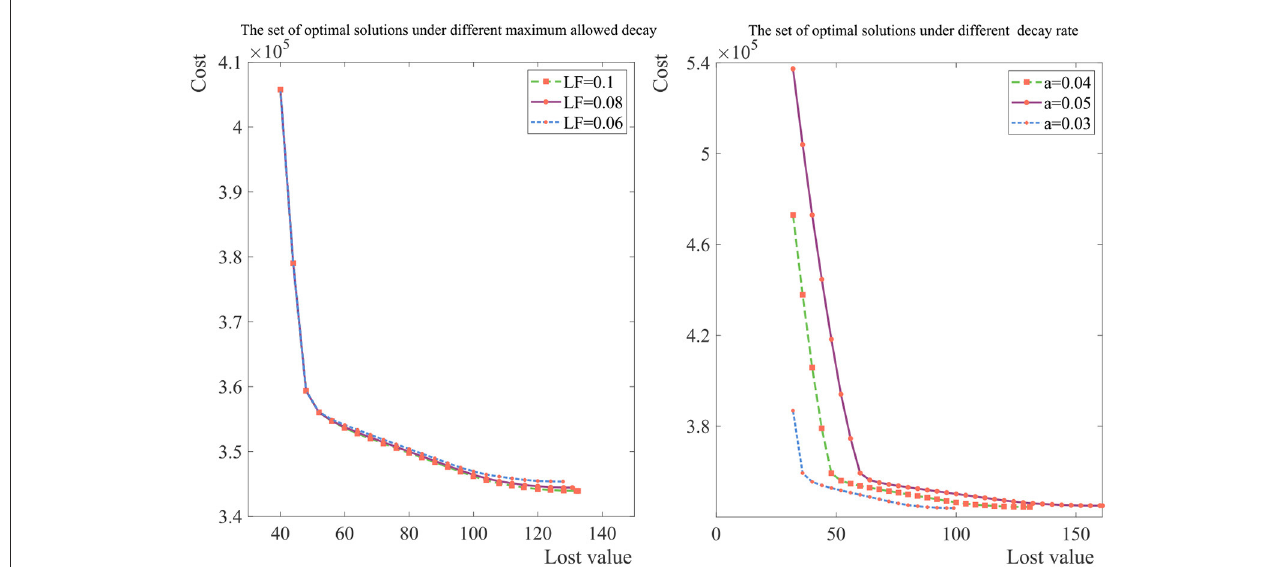
FIGURE4 Distribution of the Pareto front under the different maximum allowed decay and decay rate.